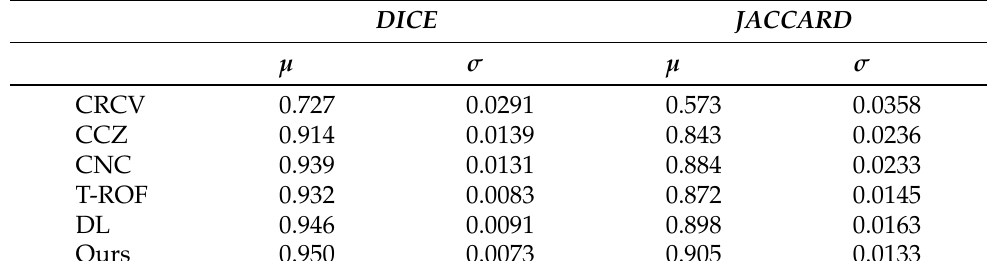
Table 1. Quantitative results from images in the DRIVE dataset. Here, we show the two methods evaluated on 20 images and display the mean and standard deviations of both the DICE coefficient and JACCARD score. Note that the DL method was trained on 15 of these 20 images.